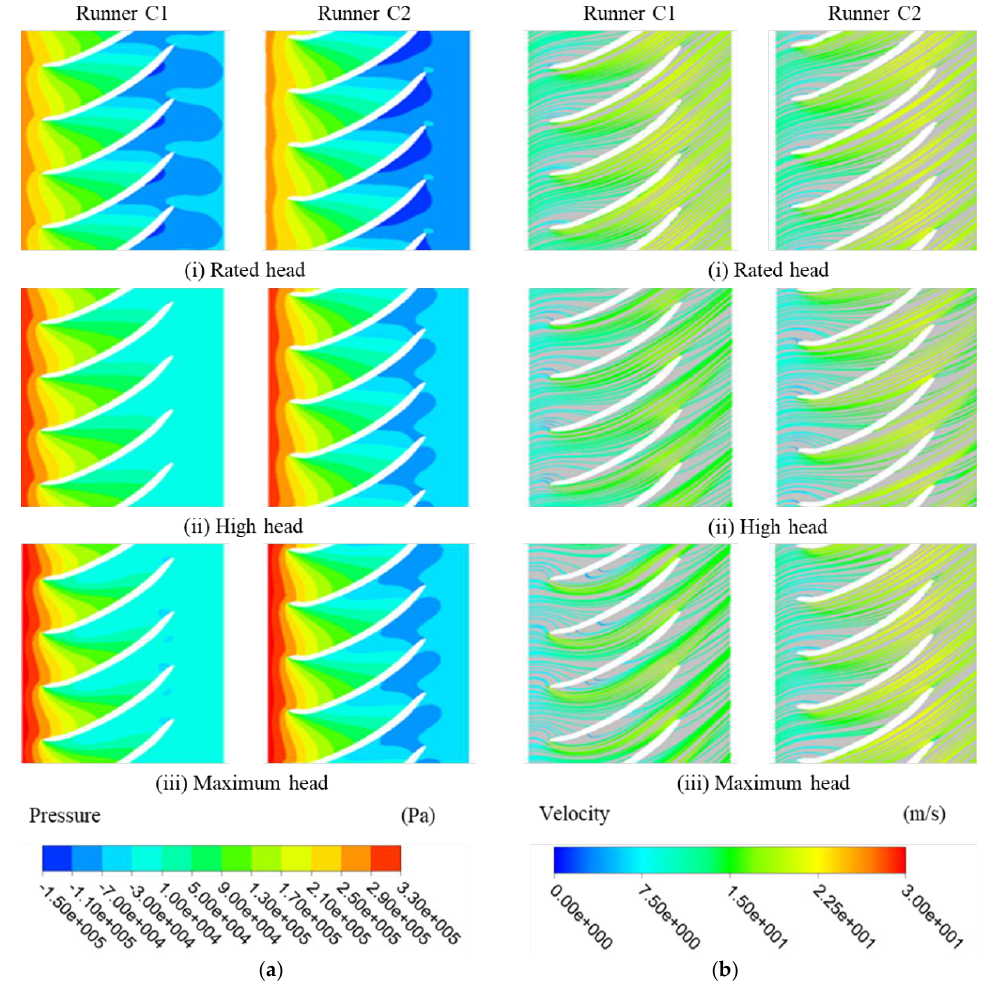
Figure 15. Flow conditions on the middle span surface of runners C1 and C2. ( a ) Pressure contours; ( b ) Surface streamlines.